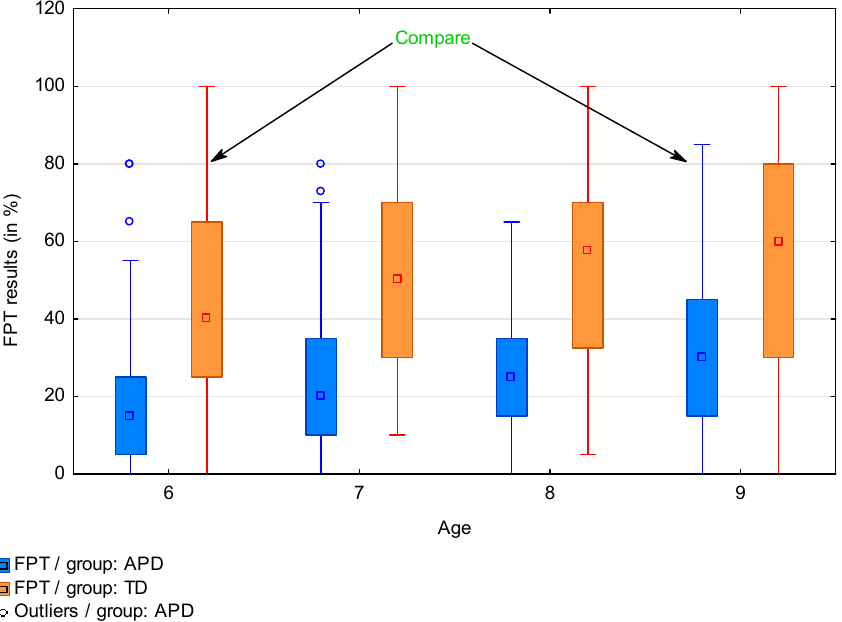
Figure 4. Comparison of the FPT results in APD and TD groups by age.